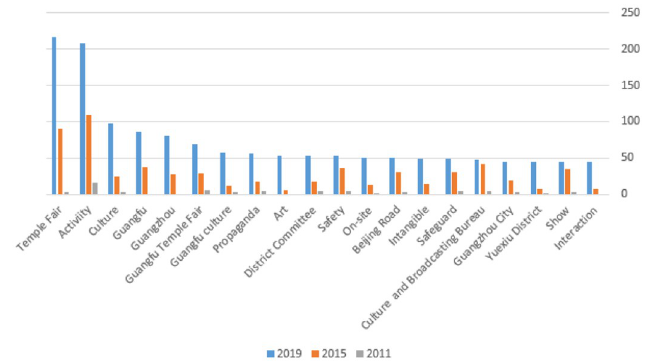
Fig 3. Comparison chart of high frequency words in Guangfu Temple